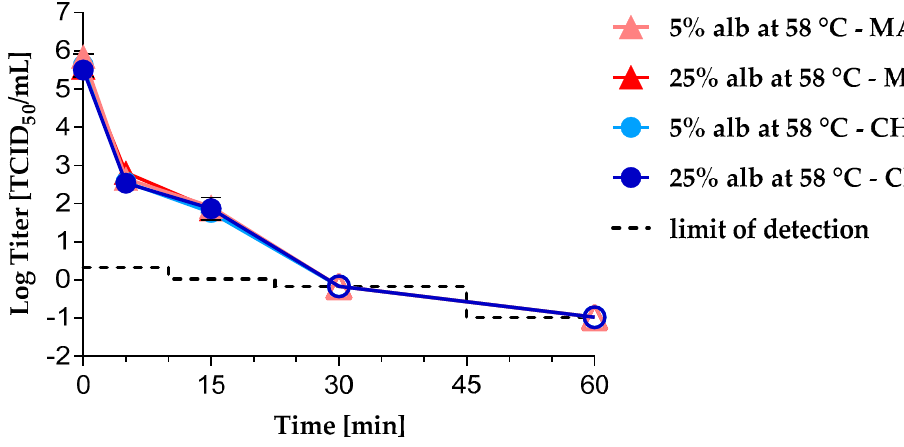
Figure 2. Heat inactivation kinetics of CHIKV and MAYV at 58 °C in 5% and 25% albumin solution. Heat-treated samples are indicated by circular (CHIKV) or triangular (MAYV) symbols. All experiments were performed in duplicate except the CHIKV treatment in 25% albumin solution ( n = 3). Error bars represent the standard deviation. Alb = albumin; closed symbols = infectivity was detected; open symbols = no residual infectivity was detected; the limit of detection depends on the sample volume tested.